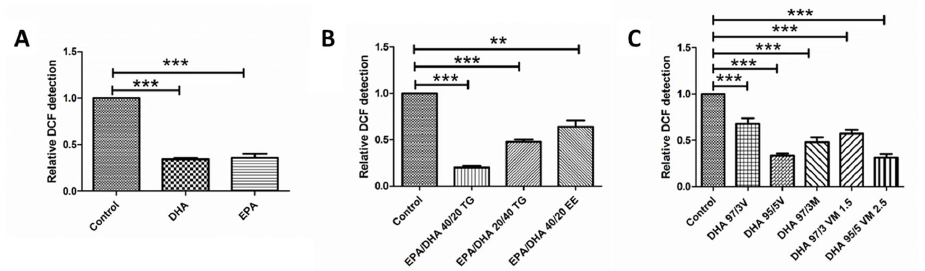
Figure 4. Graphs showing relative Dichloride fluoresceine (DCF) detection results for ARPE-19 cells in groups 1, 2, and 3 of DHA / EPA formulations, respectively ( A–C ). For comparisons, one-way ANOVA with the Bonferroni post-hoc test were used. Data are expressed as mean ± SEM. ** p < 0.01 *** p < 0.001.